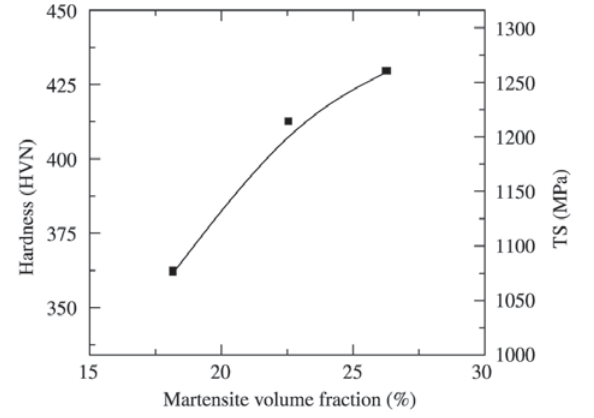
Figure 4. Vickers hardness and austenite grain size as functions of the austenitizing temperature. Standard deviations are below 10%.